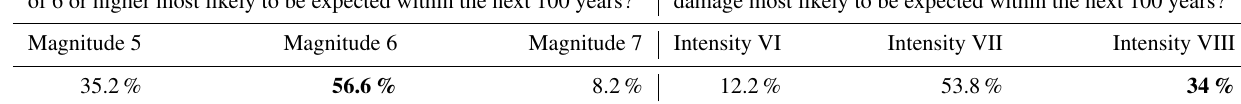
Table 9. Percentages of city pairs selected with maps displayed. The correct answers are highlighted in bold font. Which city pair has the highest probability for experiencing a magnitude 6 event or an earthquake causing severe